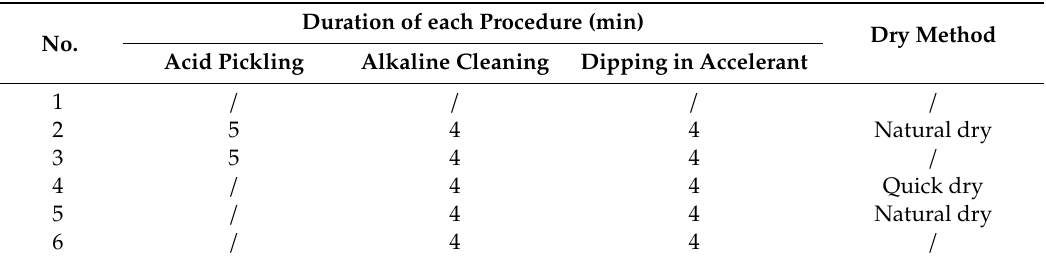
Table 4. Parameters used in pilot experiments before the hot dipping experiments.